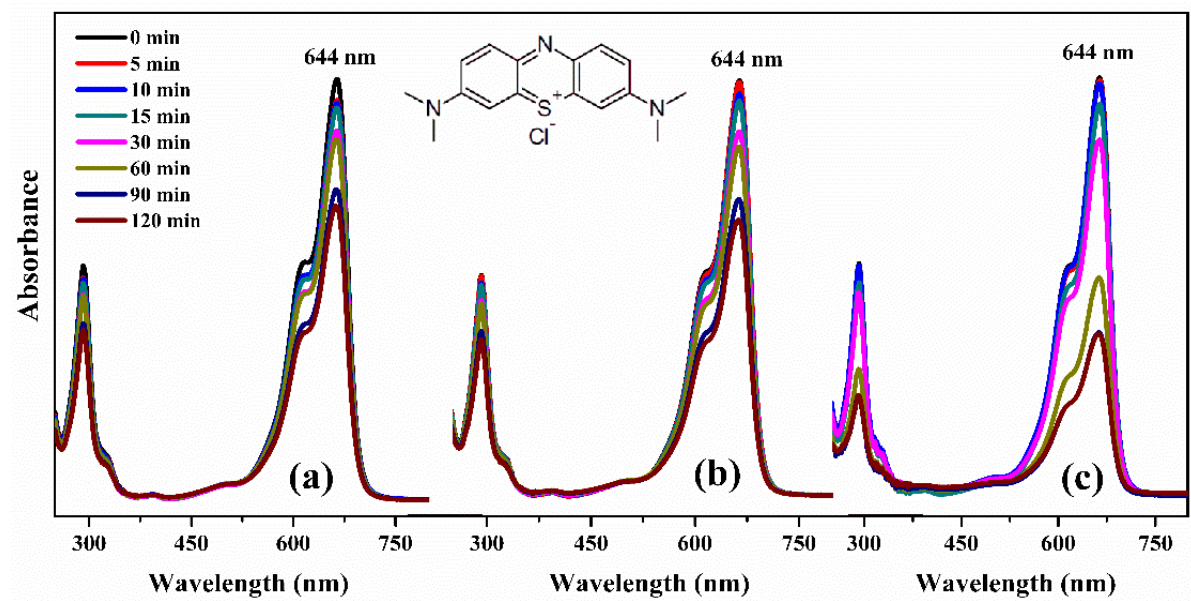
Figure 5. Absorption spectra of the irradiated MB solution using Ga-HAp photocatalyst in different concentrations: ( a ) 0.25, ( b ) 0.50, and ( c ) 1.00 g · L − 1 under UV light in different concentrations.